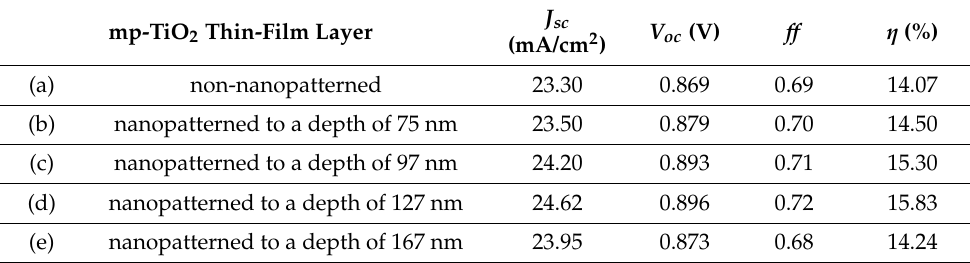
Table 1. Photovoltaic properties of perovskite solar cells with and without a nanopatterned mp-TiO 2 thin-film